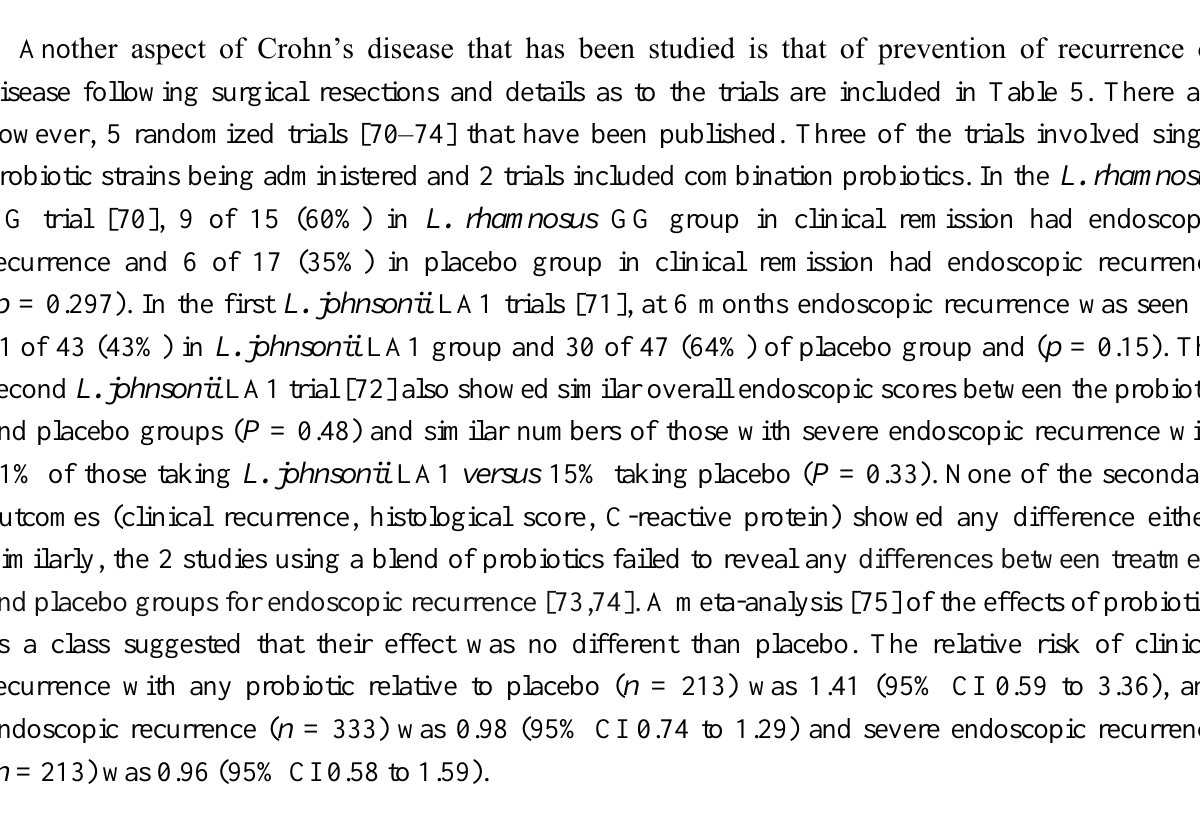
Table 5. Double-blind placebo controlled trials of probiotics for prevention of post-operative Crohn’s disease